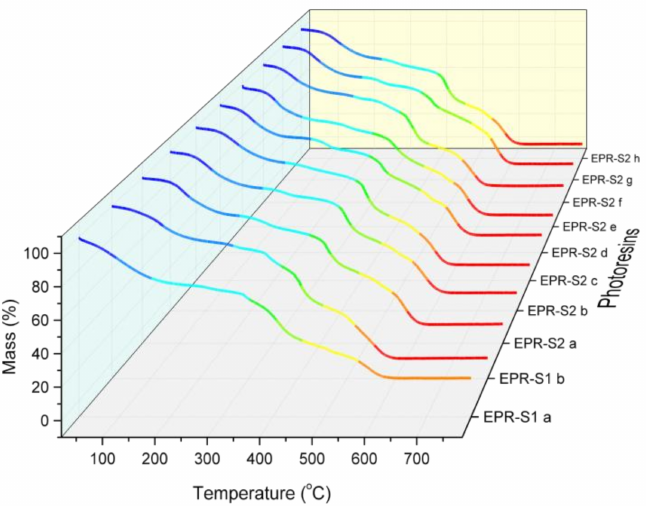
Figure 7. TGA of photo